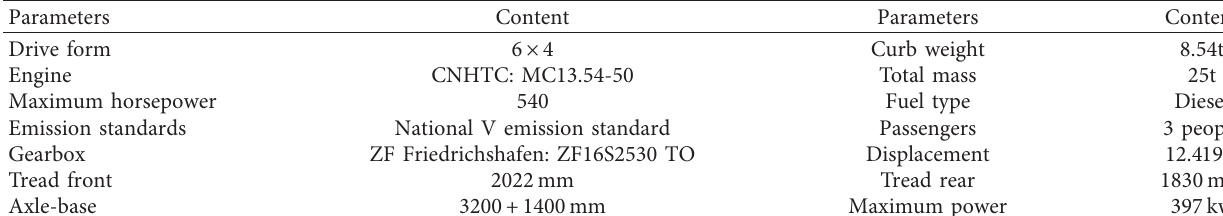
Table 2: The specific parameters of the HDDTs.